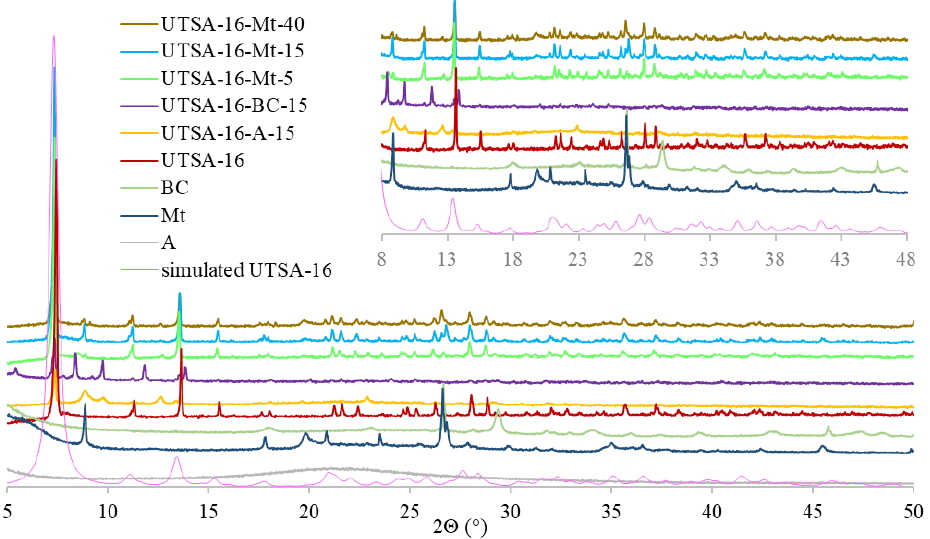
Figure 2. PXRD spectra of aerosil (A), montmorillonite (Mt), biochar (BC), UTSA-16, UTSA-16-composites containing aerosil (UTSA-16-A-15), biochar (UTSA-16-BC-15), and PXRD patterns of UTSA-16-composites containing different amounts of montmorillonite (UTSA-16-Mt-5, UTSA-16-Mt-15, and UTSA-16-Mt-40, respectively). The patterns simulated from the crystal structure data of pure UTSA-16 are shown in pink color.